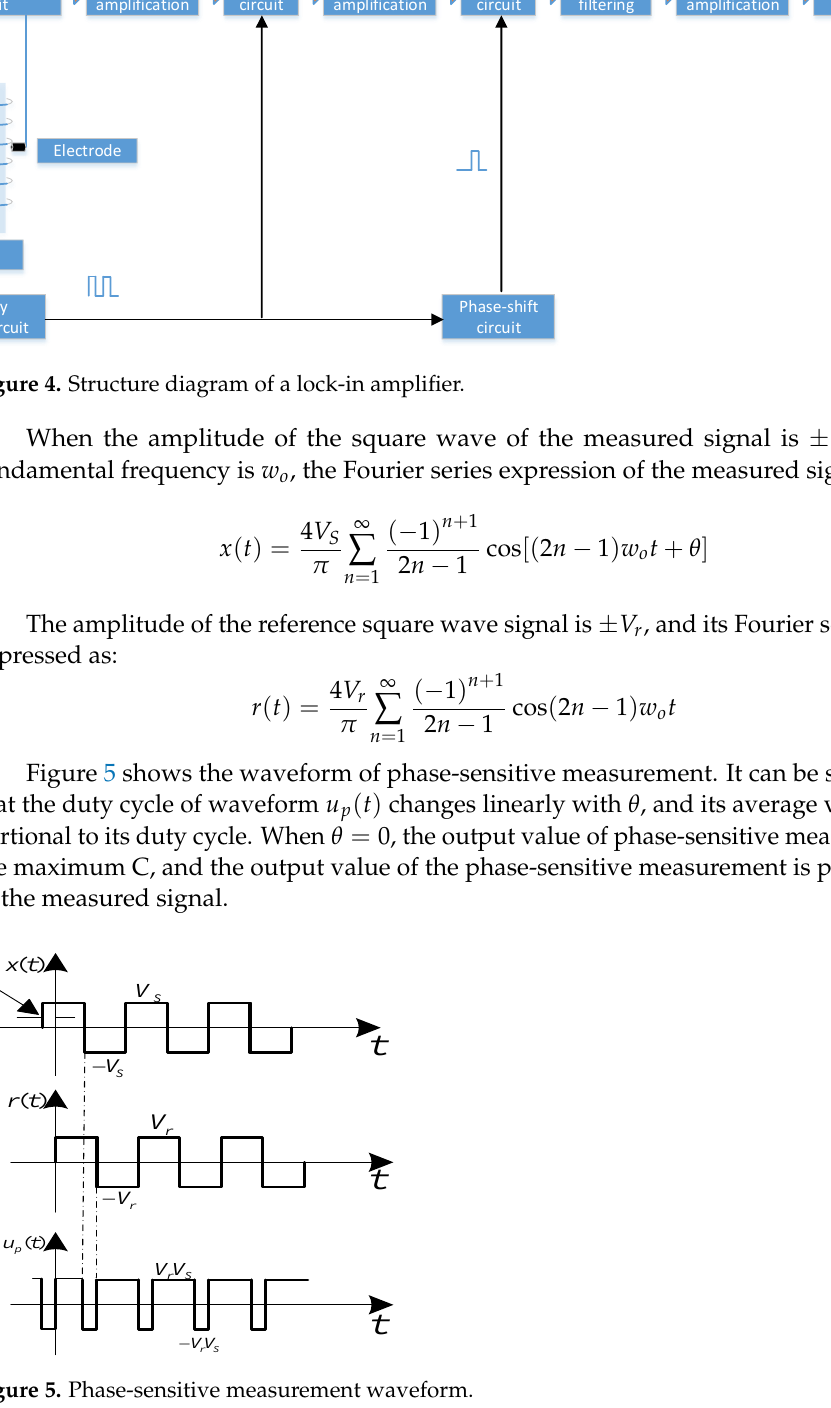
Figure 5. Phase-sensitive measurement waveform.